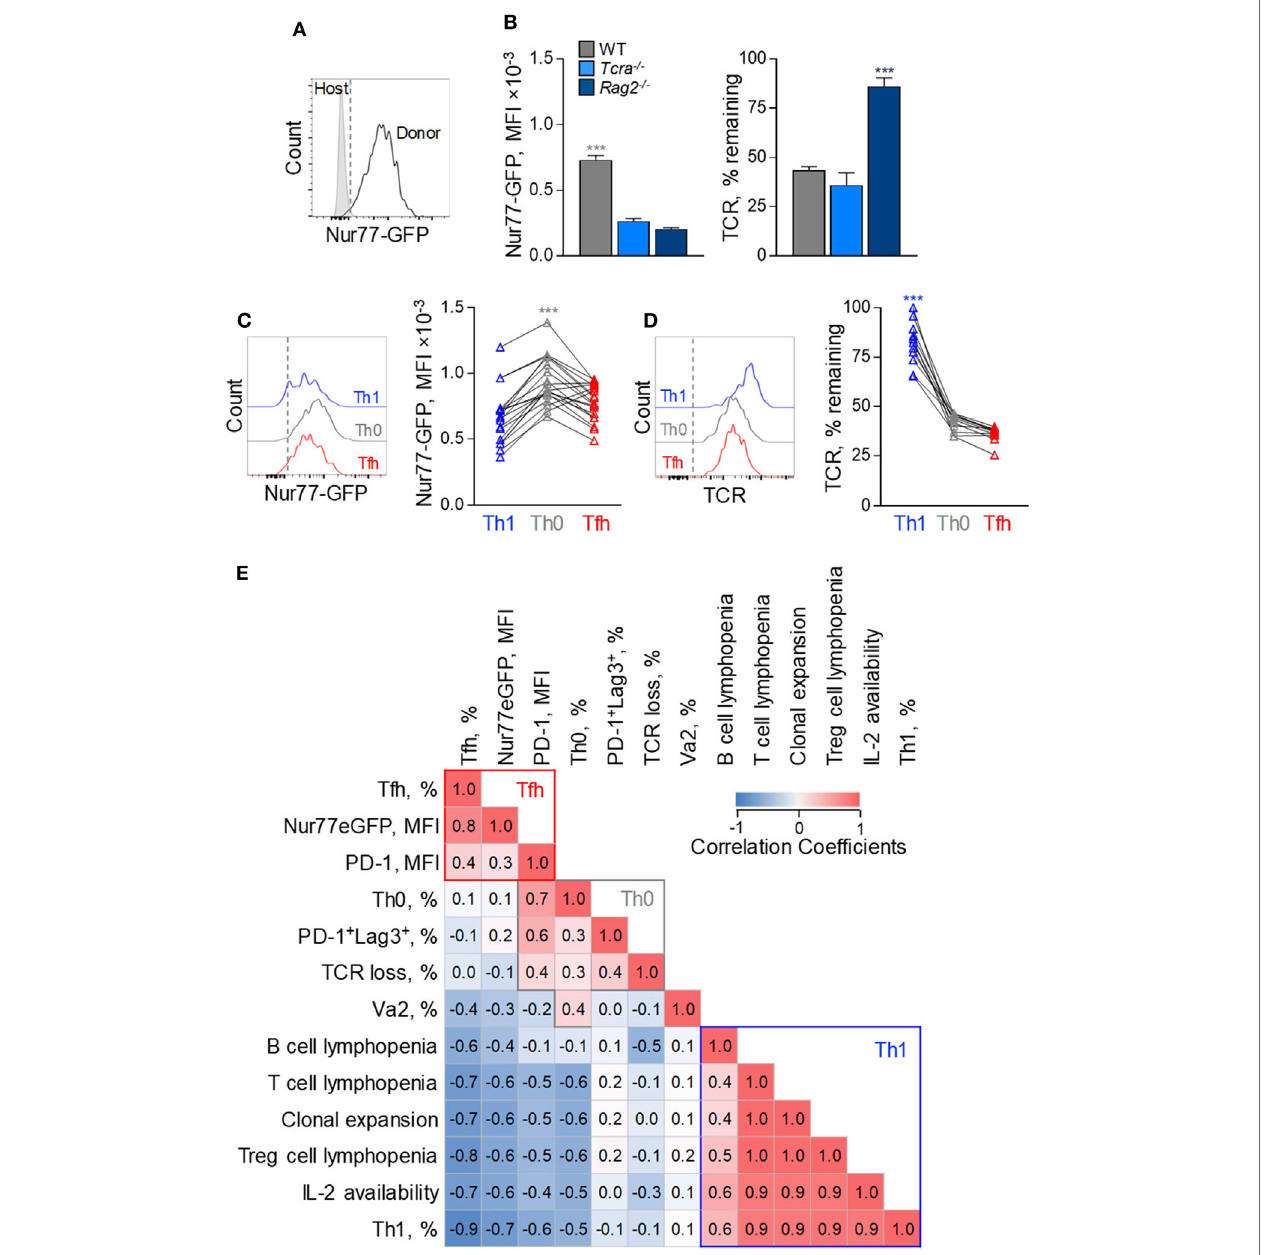
FigUre 8 | Correlates of follicular helper cells (Tfh) and Th1 CD4 + T cell response to F-MLV env. (a) Representative flow cytometric profile of GFP expression in Nur77-GFP EF4.1 doubly transgenic env-reactive donor CD4 + T cells, 7 days post transfer into Friend virus (FV)-infected WT recipients. (B) Mean fluorescence intensity (MFI) ( ± SEM) of Nur77-GFP expression ( left ) and levels of TCR β expression ( right ) in env-reactive donor CD4 + T cells, 7 days post transfer into WT ( n = 4), Tcra − / − ( n = 3) or Rag2 − / − ( n = 4) recipients, infected with an intermediate dose of FV. One representative of three experiments is shown. (c) Flow cytometric profile ( left ) and MFI of Nur77-GFP expression ( right ) and (D) flow cytometric profile ( left ) and levels of TCR β expression ( right ) in T helper (Th) subsets, defined by PSGL1 and CXCR5 expression, in env-reactive donor CD4 + T cells, 7 days after transfer into FV-infected WT recipients ( n = 19). Lines connect values from individual recipients. (e) Matrix of correlation coefficients between the indicated variables and Th subset